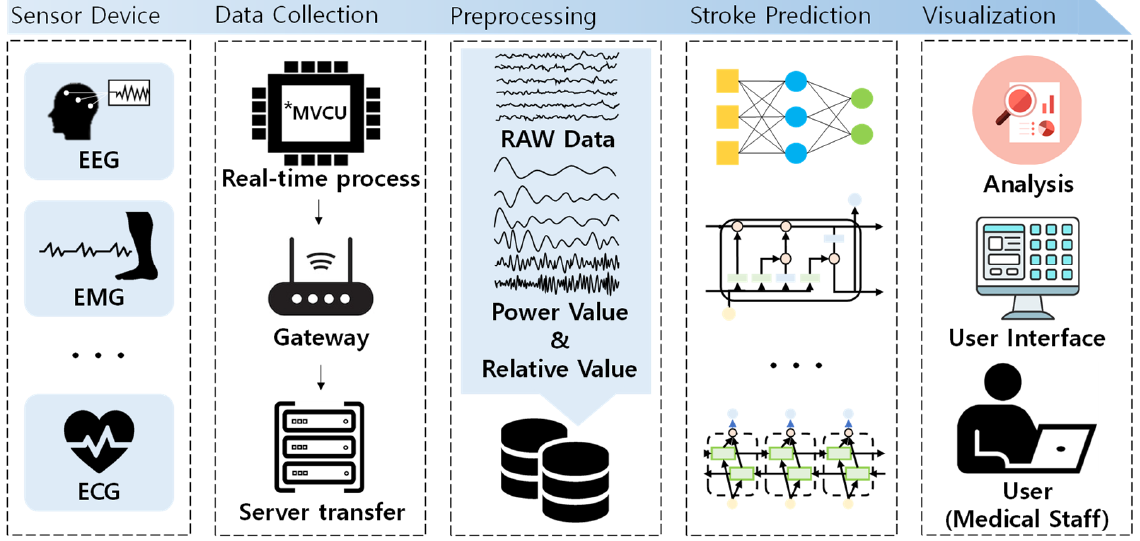
Figure 1. Elderly stroke monitoring system based on deep learning using bio signals (* MVCU: multi vital-signals collector units).